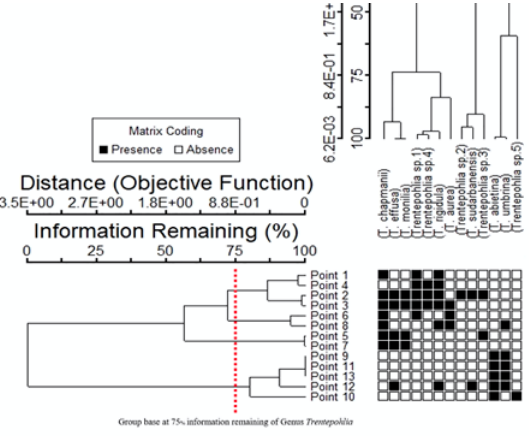
Figure 8 Similarity of algal composition by cluster analysis among 13 sampling points in the rainy, winter, and summer seasons for subaerial green algae genus Trentepohlia .